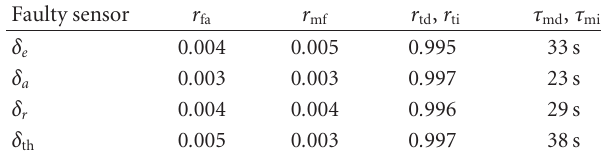
Table 9: NN Monte Carlo analysis with ν = 5.